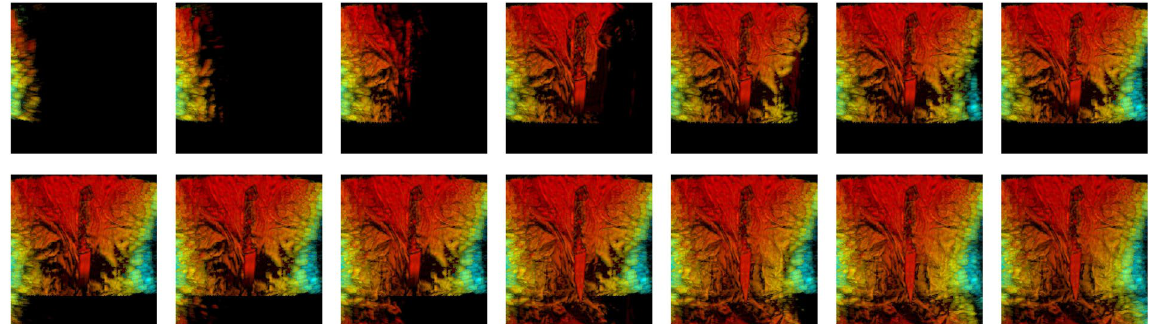
Figure 7. Cumulative image for the setup described in Fig. 6.